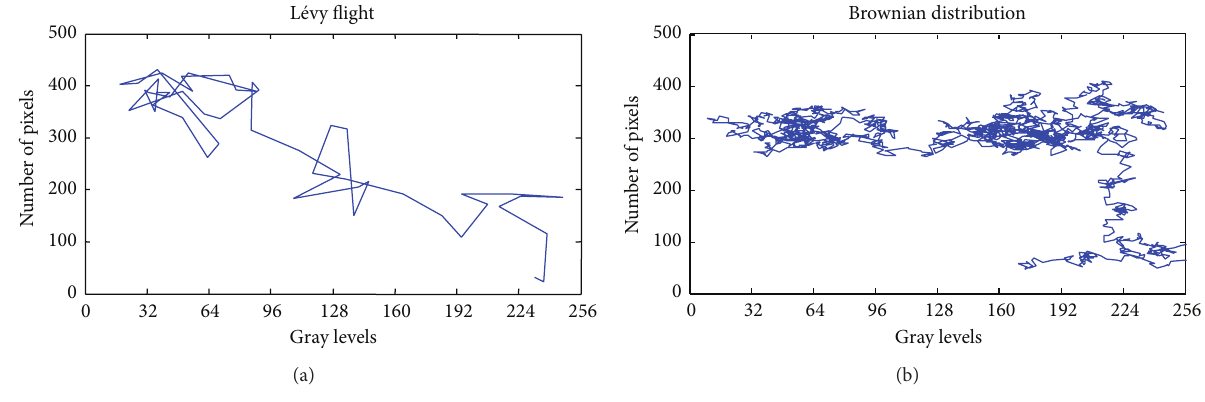
Figure 3: (a) Search pattern of a firefly with LF. (b) Search pattern of a firefly with BD.